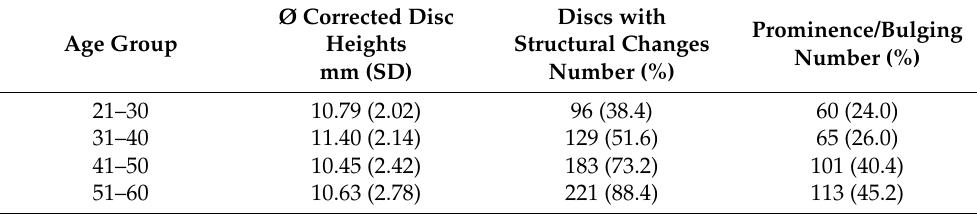
Table 3. Extent and frequency of individual criteria for the assessment of disc degeneration (average corrected disc height, percentage of discs with structural changes [signal inhomogeneities or signal attenuation] and percentage of discs with prominence [bulging, protrusion, and extrusion]). Ø Corrected Disc Discs Age Group Heights mm (SD)